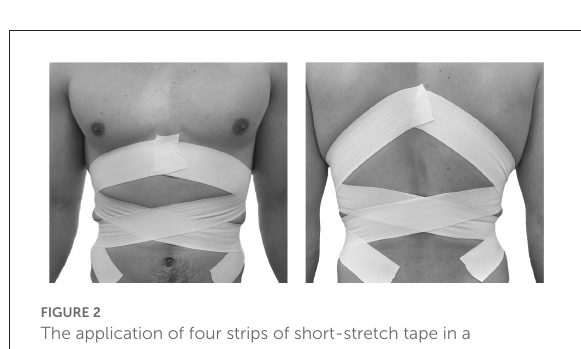
FIGURE2 The application of four strips of short-stretch tape in a clockwise and counter clockwise circular fashion to impede the pelvic and trunk